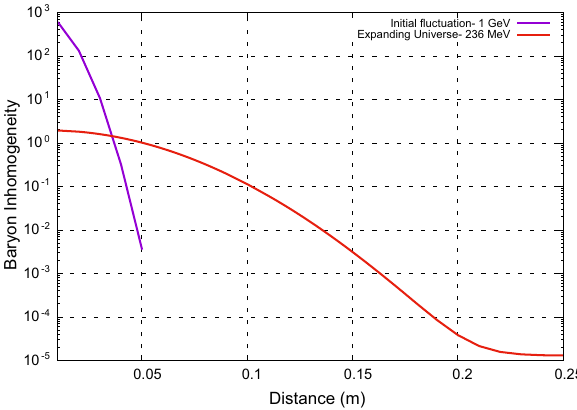
Fig. 6 The decay of the fluctuation is shown in log scale between 1 GeV and 236 MeV for a plasma where a quark is moving through neutrinos.Sincetheinhomogeneitydecaysfasterhere,asthemagnitude goes down, the radial distance increases. The full curve at 236 MeV is notgiven,itiscutoffatsomepointwherebaryoninhomogeneityisclose to 0 . 01. Compared to the initial fluctuation which had an amplitude of 10 3 , this can be taken to be zero